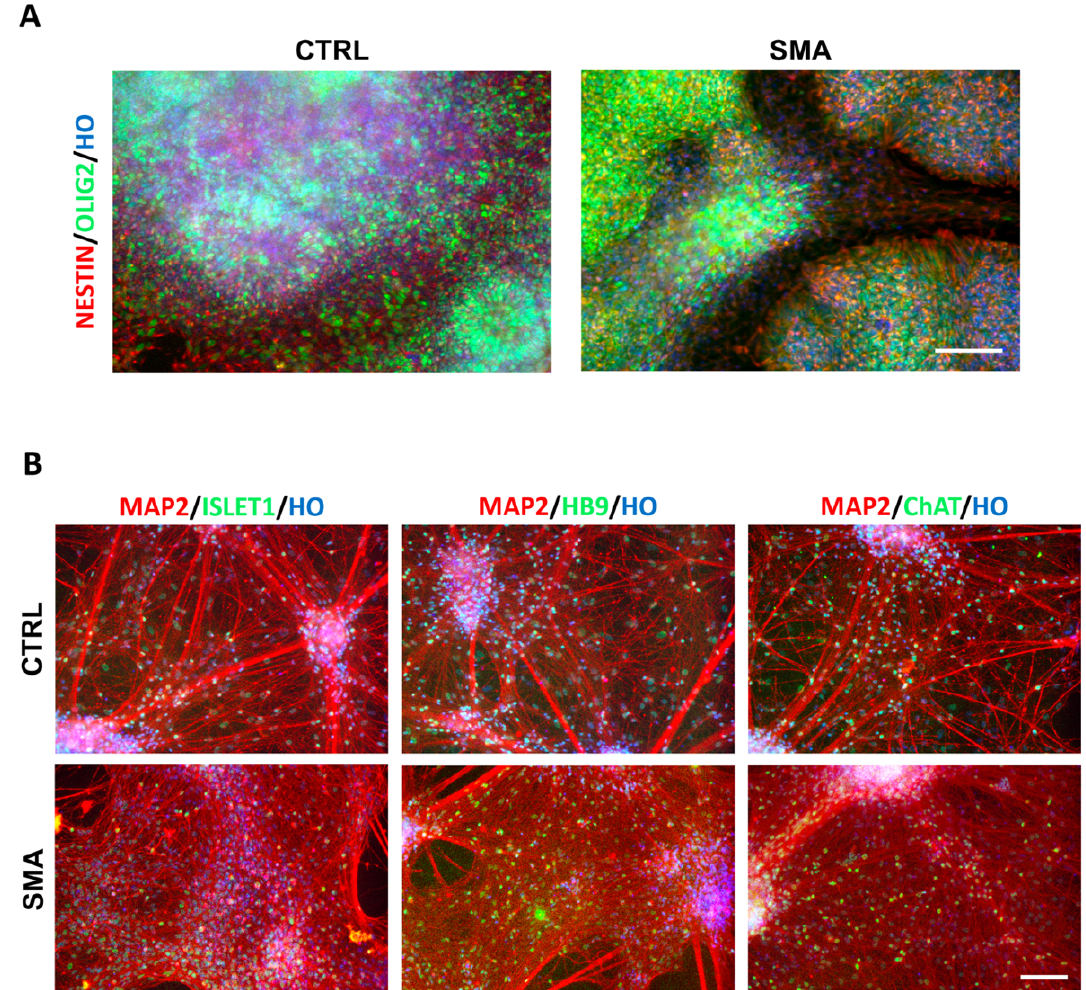
Figure 8. Generation of MNPCs and MNs from SMA patient-derived hiPSCs. ( A ) Representative pictures of DIV13 cultures differentiated from hiPSCs from a healthy individual (CTRL) and an SMA patient. Nuclei are stained with Hoechst (HO). ( B ) Representative pictures of 4-weeks mature MNs differentiated from hiPSCs derived from a healthy individual (CTRL) and an SMA patient. Immunofluorescent analyses for MAP2 along with different MNs markers are shown. Nuclei are stained with Hoechst (HO). Scale bar: 100 μ m.